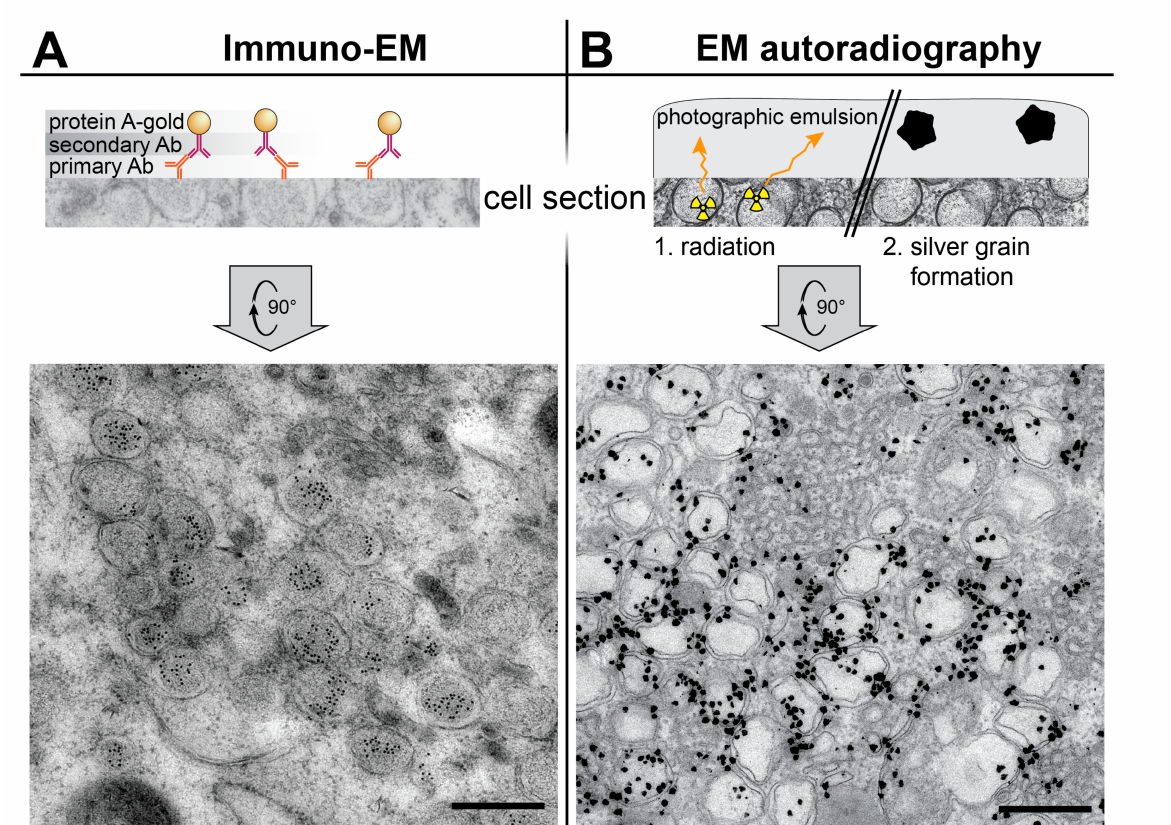
Figure 3. Labeling EM techniques applied to the study of the coronavirus ROs. ( A ) Immunoelectron microscopy (IEM) detection of dsRNA inside the DMVs induced by SARS-CoV in Vero E6 cells (adapted from [15]). On-section immunogold labeling was performed on sections from plunge-frozen freeze-susbstituted cells using a primary antibody (Ab), a secondary antibody, and protein A conjugated with 10 nm gold. ( B ) EM autoradiography detection of active viral RNA synthesis showing it is associated to coronaviral DMVs. Tritiated uridine was provided to live Huh7 cells infected with MERS- CoV, so that the radioactive label could be incorporated into newly-synthesized viral RNA. After 30 min, the cells were chemically fixed, prepared for EM, sectioned, and covered by a thin layer of photographic emulsion. In EM autoradiography, the radioactive disintegrations that arise from the sample in random directions create defects in the emulsion that give rise to electron-dense silver grains upon development. The image shows the high density of label in areas containing MERS-CoV-induced DMV (adapted from [39]). Scale bars, 500